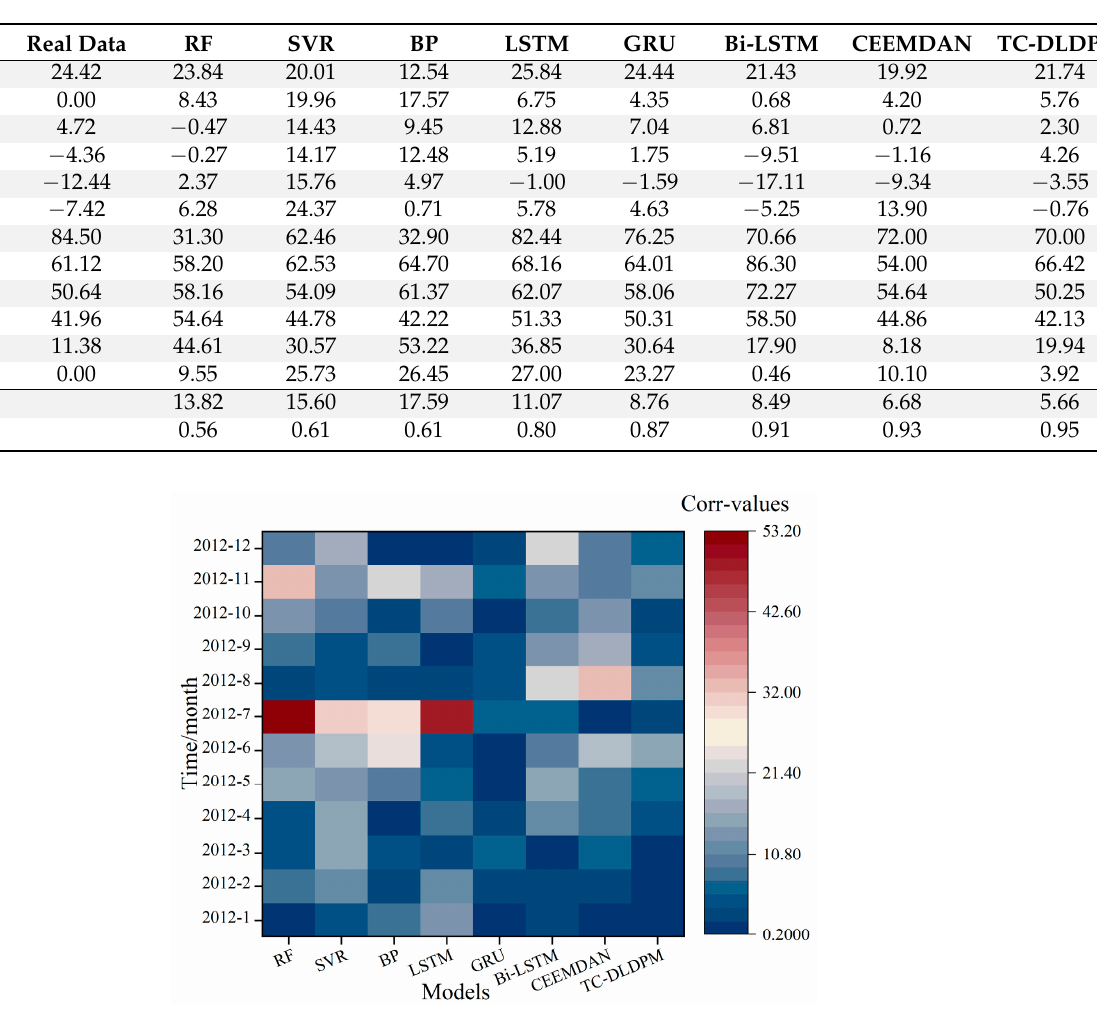
Table 3. Comparison of the prediction accuracy and the error of periodic term displacement by the different prediction models.